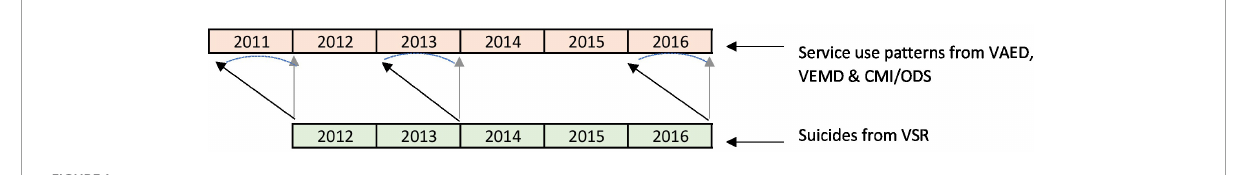
FIGURE1 Schematic diagram of the data linkage time